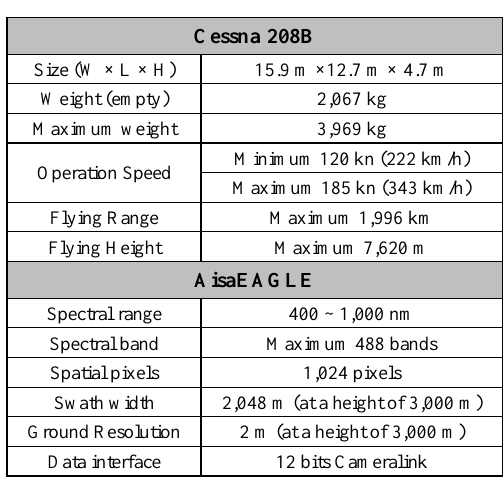
Table 1 . Information regarding the Cessna 208B aircraft and AisaEAGLE hyperspectral